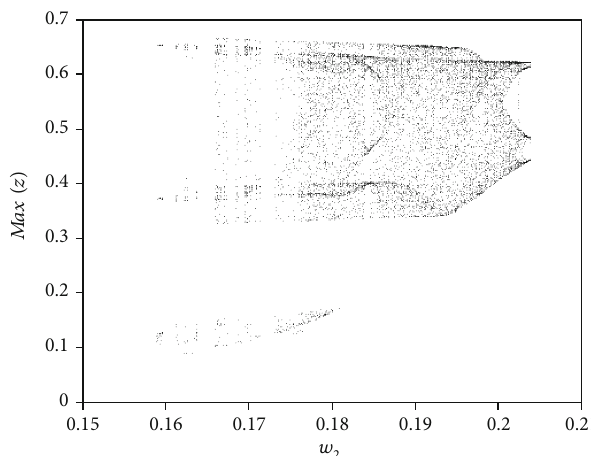
Figure 7: Bifurcation diagram of system (3) using data (87) with varying w 2 , the trajectory of z versus w 2 in the range ð 0 : 15, 0 : 21 Þ